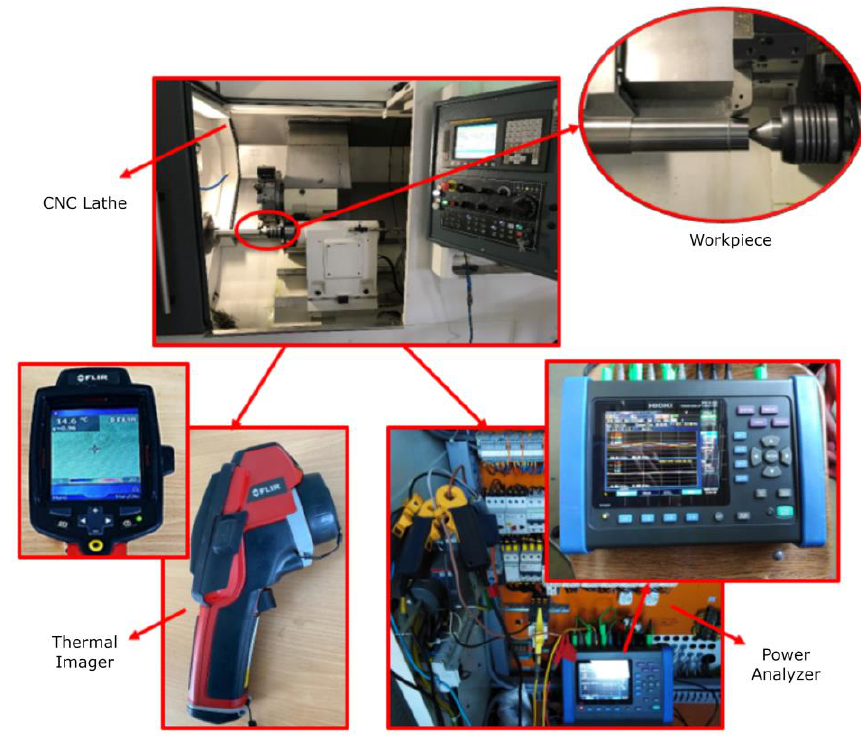
Figure 9. The experimental setup.